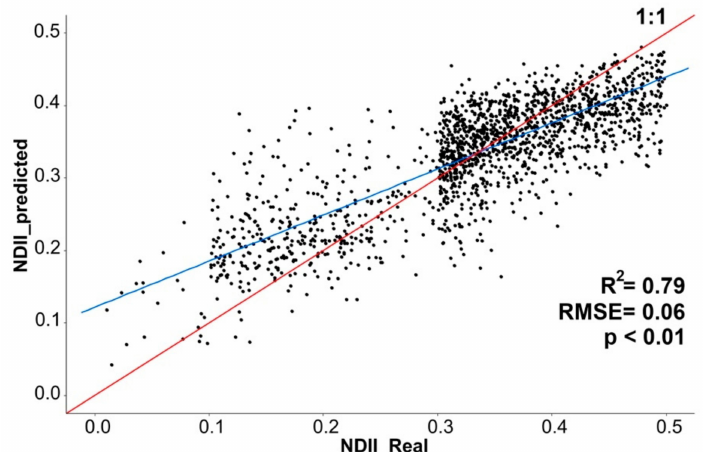
Figure 6. Comparison between real and predicted Landsat derived NDII index values based on a Random Forest model with the most significant environmental variables (minimum temperature of February, and precipitation of June, September and March) to describe Pine Processionary Moth defoliation levels for the southeastern Andalusia Pinus forests. Red line: represents 1:1; Blue line: random forest